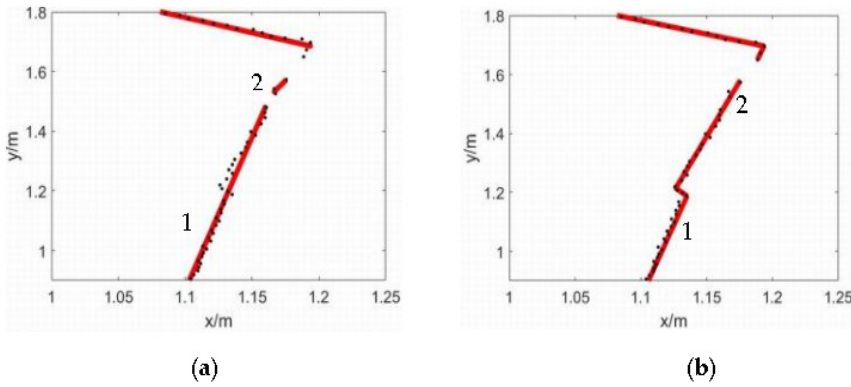
Figure 12. Area 3 line fitting results: ( a ) PDBS algorithm; ( b ) proposed algorithm.